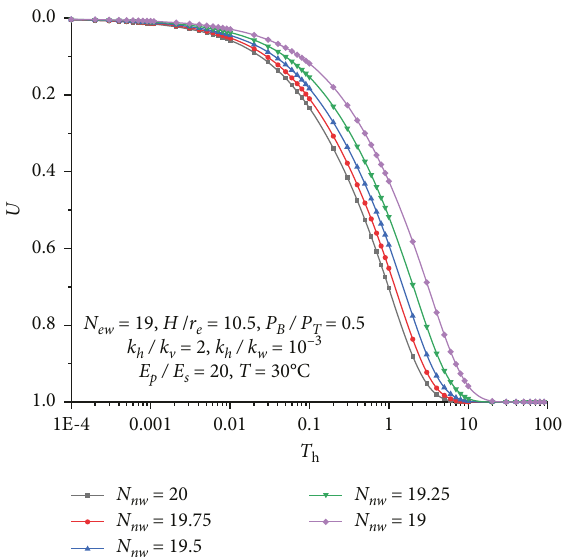
Figure 5: Effect of impervious pile replacement rate on foundation consolidation.